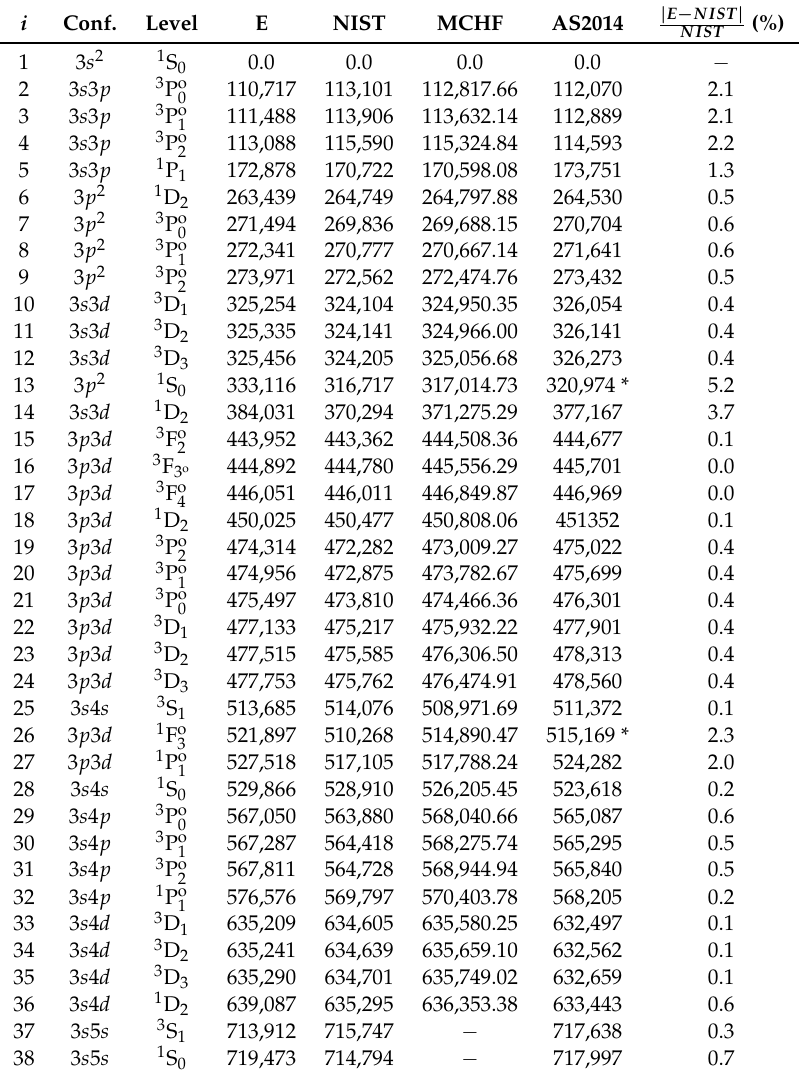
Table 1. Our present fine-structure energy levels E (in cm − 1 ) for Ar VII compared with those of NIST [22], with those obtained from the multiconfiguration Hartree–Fock method (MCHF) [24], and with those from the R-matrix calculation (AS2014) [25]. Levels denoted by asterisks (*) are inverted compared to the NIST